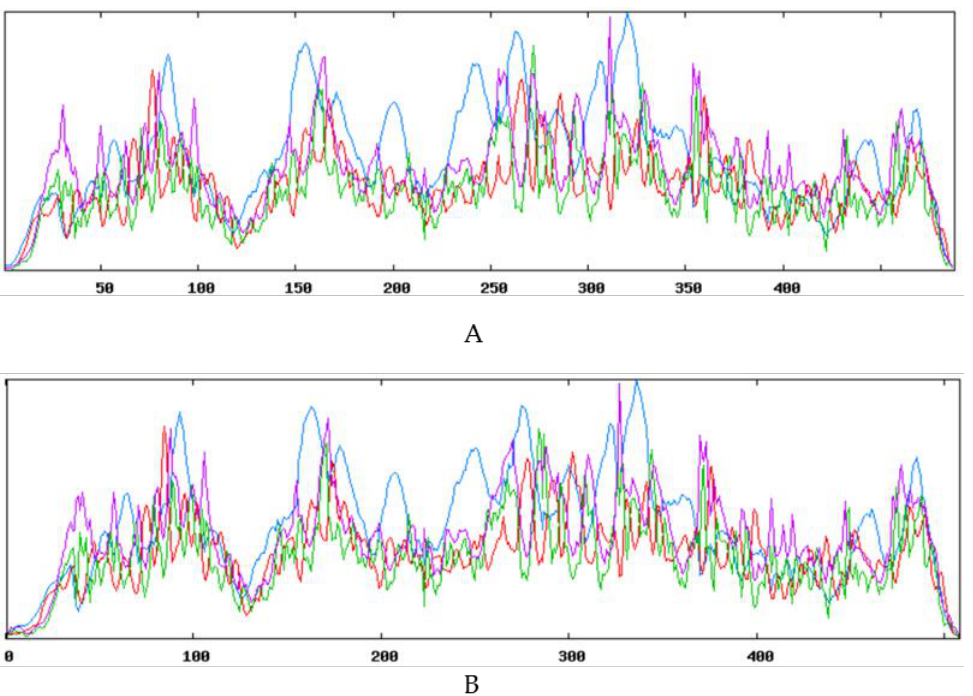
Figure A4. Secondary structures of ( A ) Xs GAO1 and ( B ) Xs GAO2. α-helixes are indicated in blue, β-sheets are indicated in green, and random coils are indicated in red.